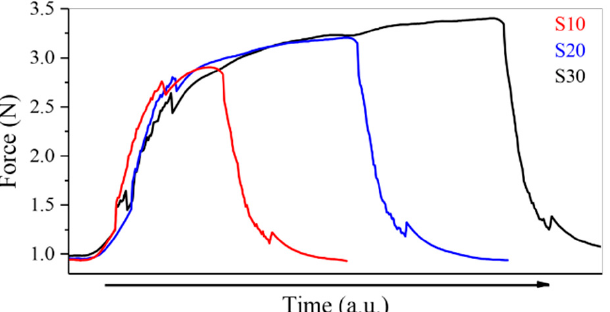
Figure 7. Force vs. time of the thermal cycle of the NiTi spring (tensile test) (10 s (S10), 20 s (S20), and 30 s (S30)).